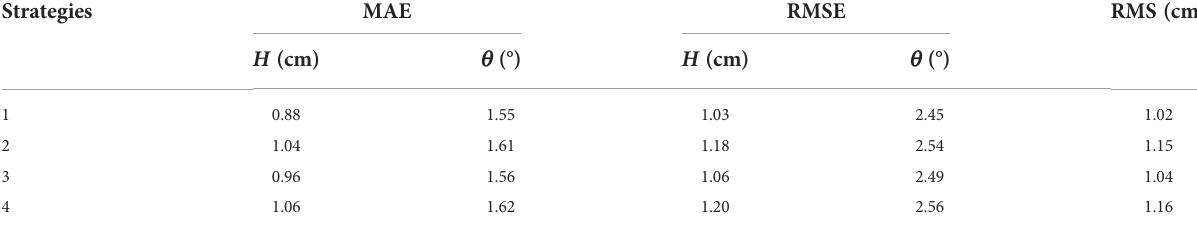
TABLE 2 Differences between SOs and re-estimated HCs obtained by inversion of OBCs. Strategies